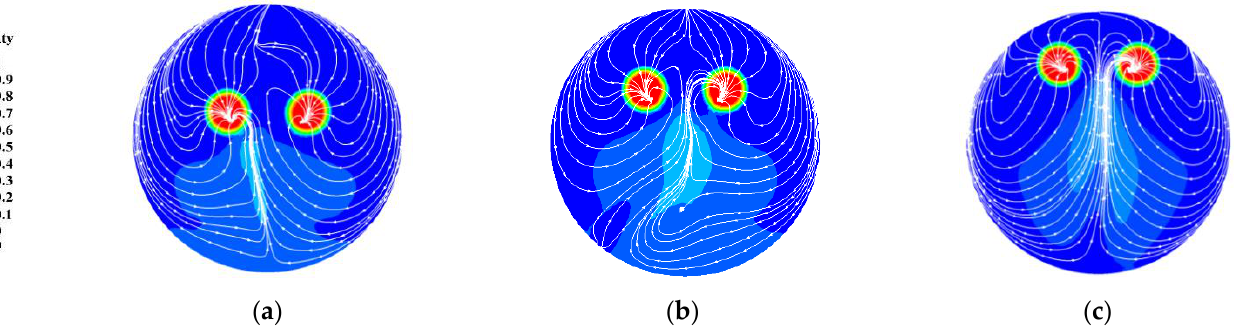
Figure 8. Streamline and velocity distribution nephogram of Section 4-4 under different L values: ( a ) L = 0.2 R ; ( b ) L = 0.4 R ; ( c ) L = 0.6 R.